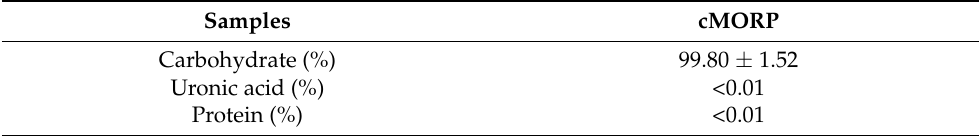
Table 4. Chemical composition of